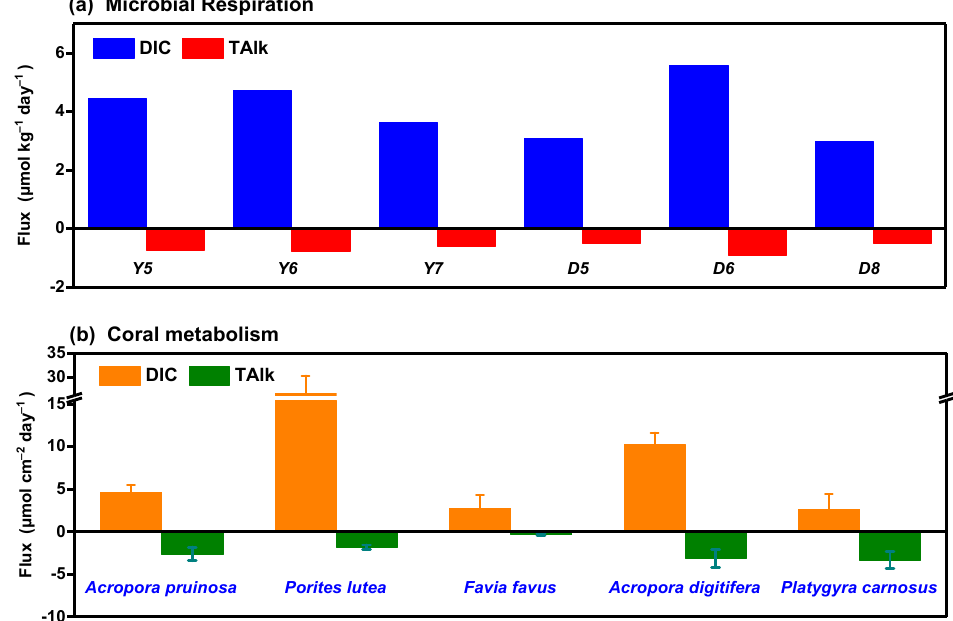
Figure 4. Effects of microbial respiration ( a ) and coral metabolism ( b ) on TAlk and DIC dynamics.